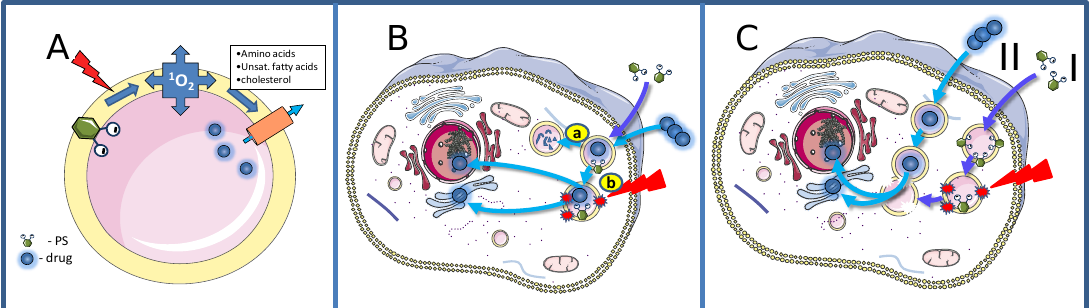
Figure 3. Schematic description of the PCI technology. ( A ). The figure shows an endocytic vesicle with a PS located in the vesicle membrane (inner leaflet) that upon light exposure induce ROS, primarely singlet oxygen ( 1 O 2 ) that oxidize biomolecules in the membrane making it permeable for the drugs in the matrix of the endocytic vesicles. ( B ). Drugs that are endocytosed may accumulate in lysosomes were they will be subjected to enzymatic hydrolyses and unable to exert any therapeutic effect (pathway a). Alternatively, drugs may be released into cytosol by means of PCI before enzymatic degradation and reach the target of their therapeutic effect in the nucleus or in the cytoplasm (pathway b). ( C ). In the “light first procedure” the PS is first administrated to the cells (step I) followed by light exposure. After the light exposure is finished the drug to be transported to the extraendolysosomal part of the cells will be administered (step II), endocytosed and fused with photochemically ruptured endolysosomes and thereby released into the cytosol according to the hypothesis.